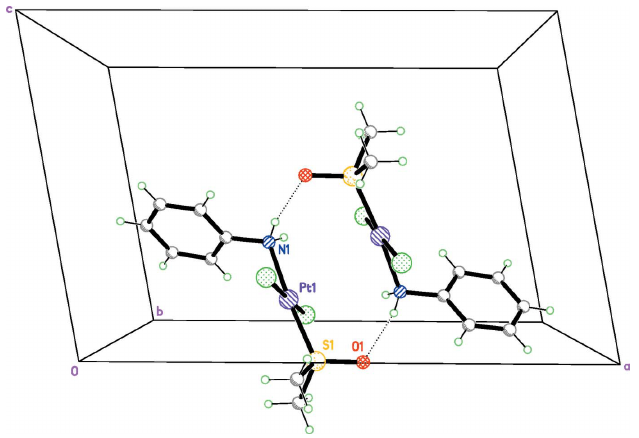
Figure 2 The N—H (cid:3)(cid:3)(cid:3) O hydrogen-bonding interactions between the amine H- atom donors and dimethyl sulfoxide O-atom acceptors in the title compound.